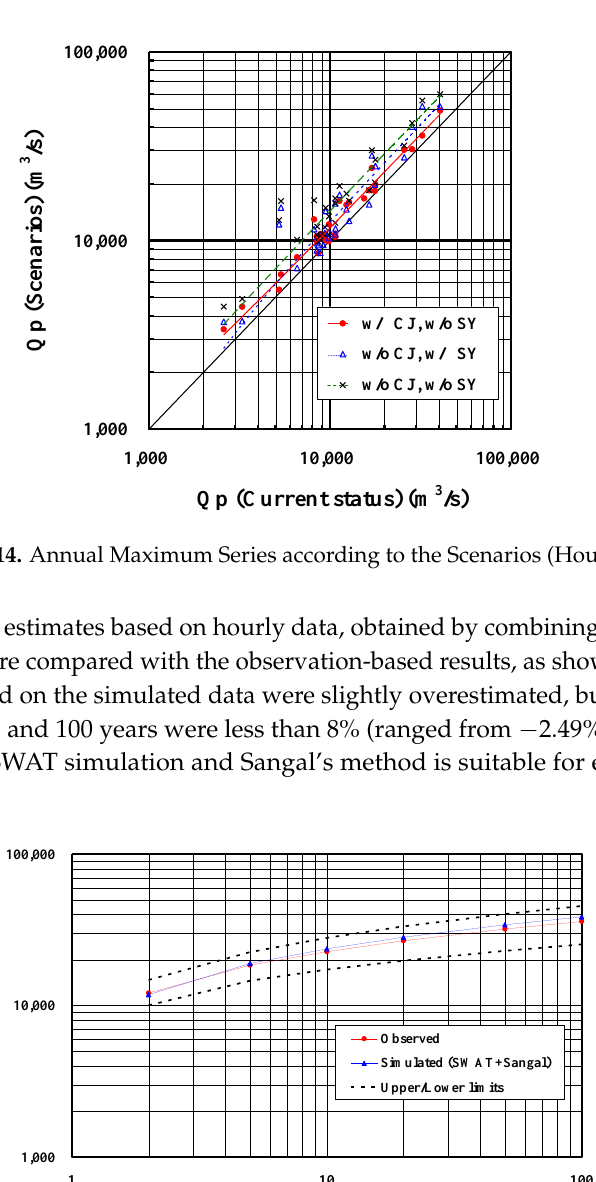
Figure 15. Observed and Simulated Floods for different Return Periods at the Paldang Dam (Hourly). T-year represents the different Return period.